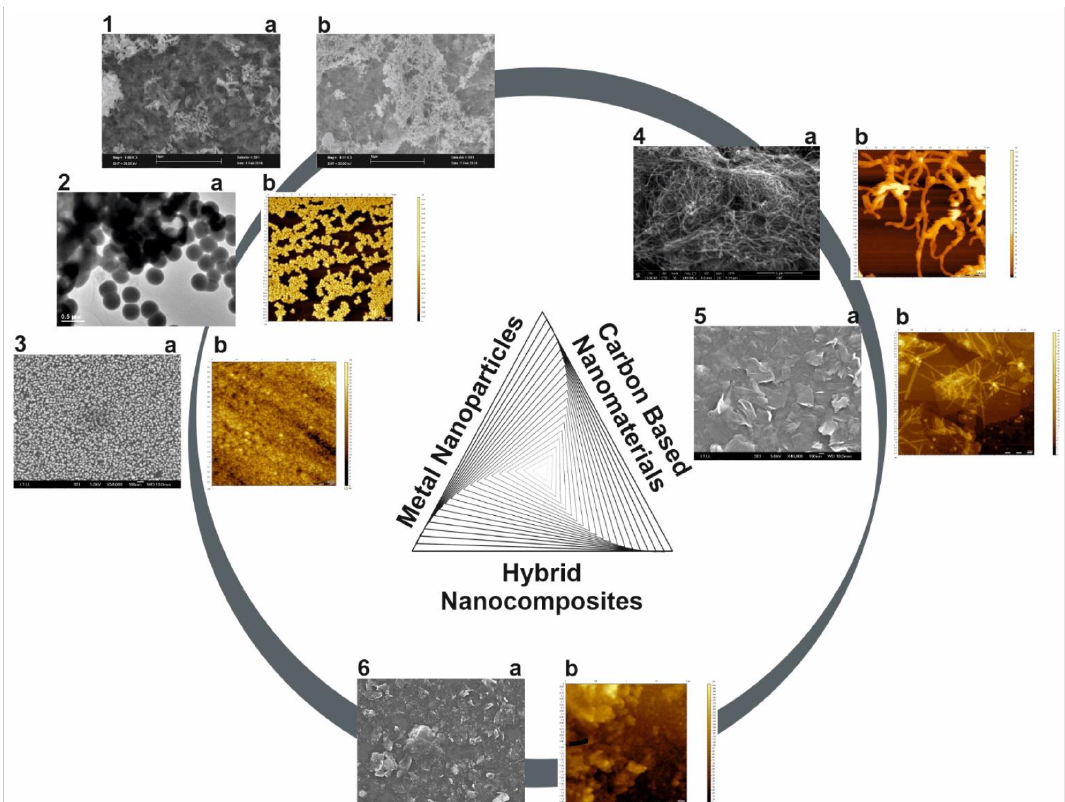
Figure 1. Microscopic images of some metal nanoparticles (1a—SEM image of TiO 2 NPs, 1b—SEM image of TiO 2 doped with SeNPs; 2a—TEM image of SeNPS; 2b—AFM image of SeNPs; 3a—SEM image of AuNPs, 3b—AFM image of AuNPs), carbon-based nanomaterials (4a—SEM image of MWCNTs, 4b—AFM image of MWCNTs; 5a—SEM image of graphene, 5b—AFM image of graphene) and hybrid nanocomposite (6a—SEM image of graphene + AuNPs, 6b—AFM image of graphene + AuNPs) (original